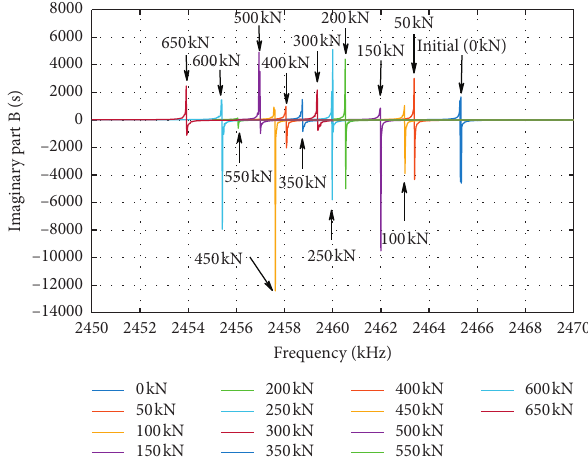
Figure 17: Admittance signatures at different load conditions for column #2.